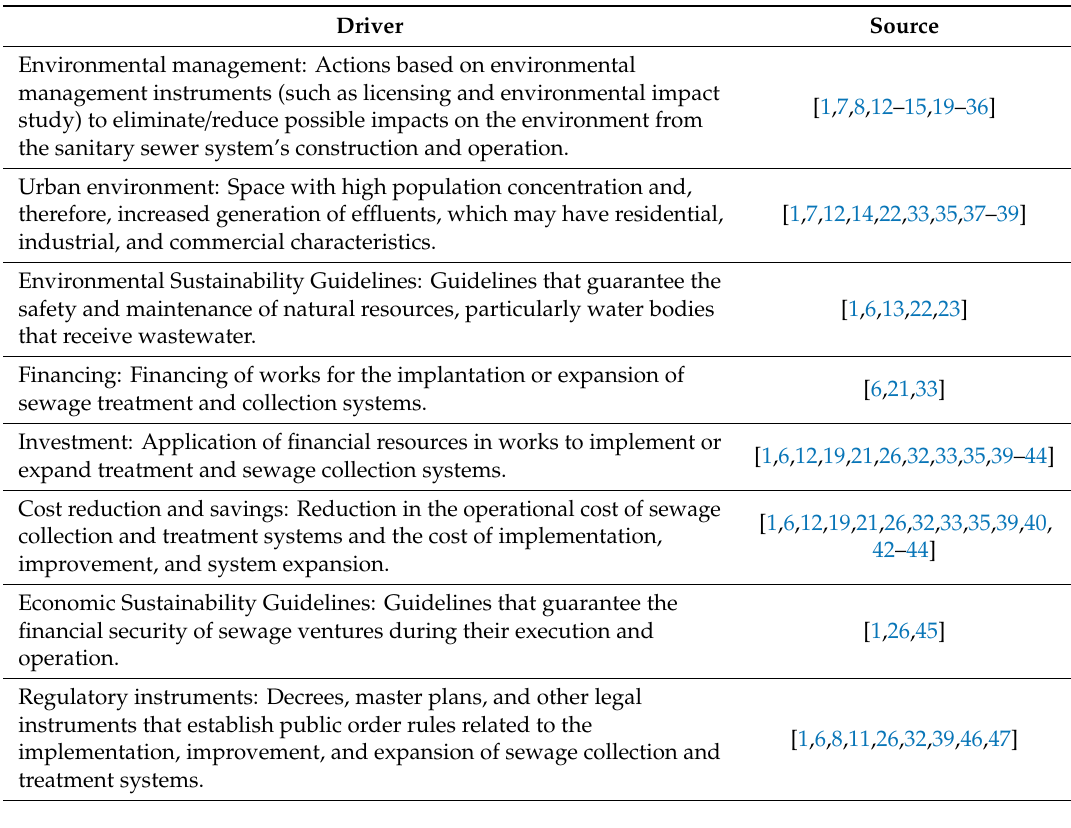
Table 1. Drivers for increasing the intelligence of urban sanitary sewage